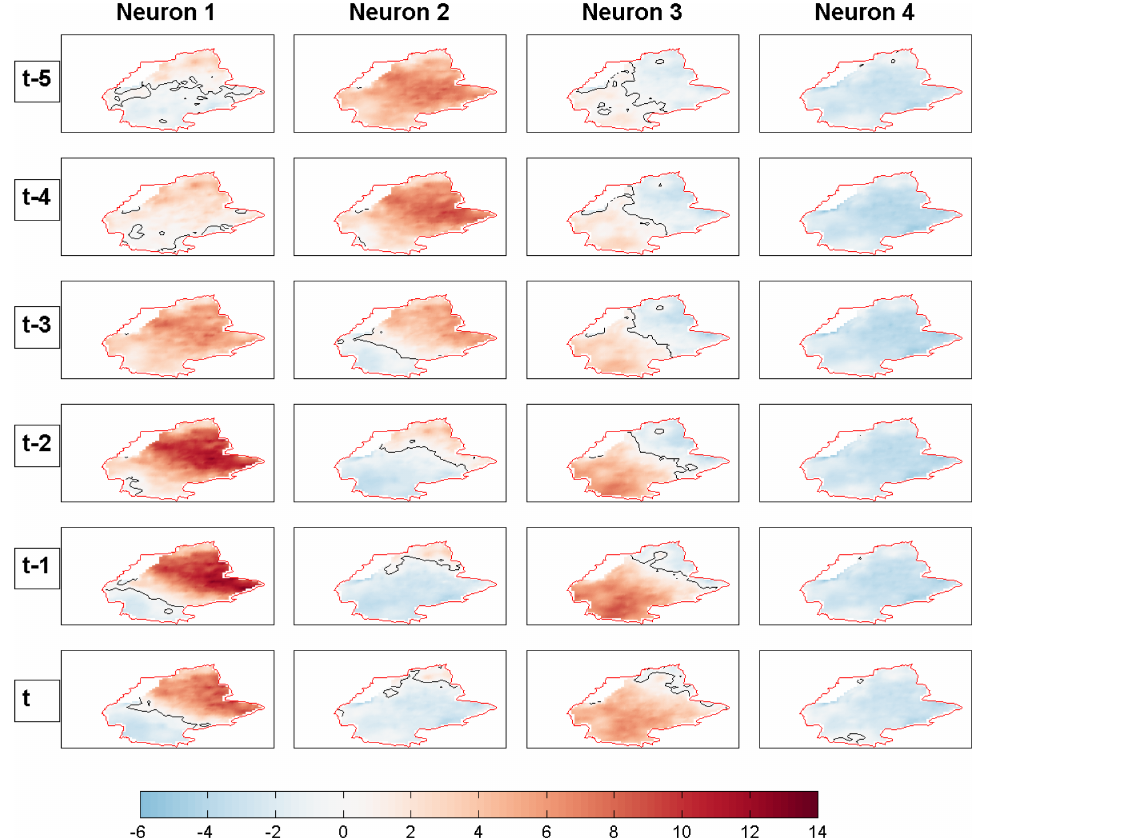
Figure 3. Neuron weights obtained for the SOM. These weights basically represent the rainfall anomalies (in millimeters) over the Upper Paraná River basin from day t − 5 (top panels) to day t (bottom panels). The black line shows the zero